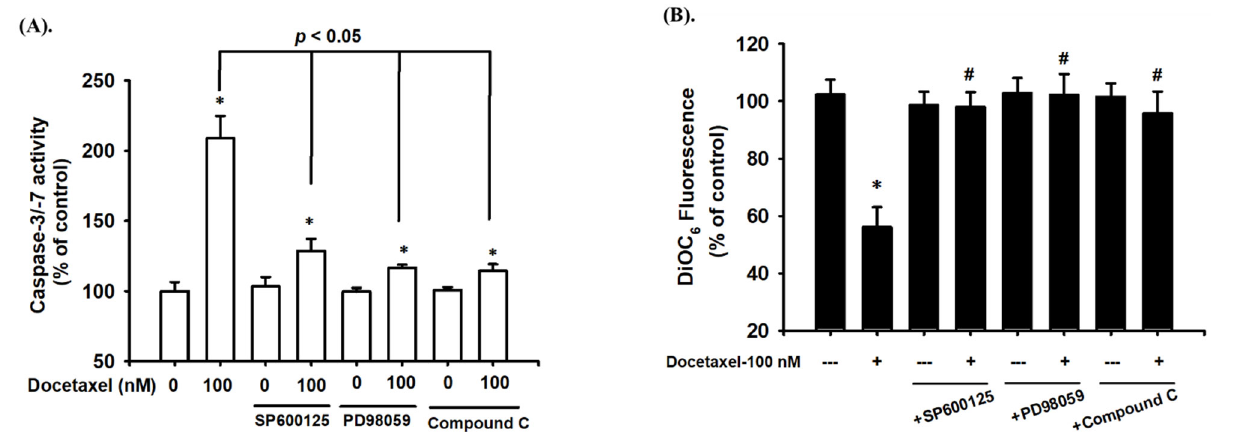
Figure 4. The roles of MAPKs and AMPK in docetaxel-induced apoptotic activity and mitochondrial damage-related signals in human tongue squamous carcinoma-derived SAS cells. Cells were pretreated with SP600125 (a JNK inhibitor; 20 µ M), PD98059 (an MEK1/2 inhibitor; 20 µ M), and compound c (an AMPK inhibitor; 10 µ M) for 1 h and then treated with or without docetaxel for 48 h. ( A ) The caspase-3/-7 activity was determined using a caspase-3/-7 activity assay kit. ( B ) The MMP was determined by flow cytometer with a fluorescent dye DiOC 6 . Data in ( A , B ) are presented as the means ± SD of four independent experiments with triplicate determination. Statistical analysis was performed with one-way ANOVA analysis followed by Tukey’s post hoc test. * p < 0.05 compared with vehicle control. # p < 0.05 compared with docetaxel treatment group.